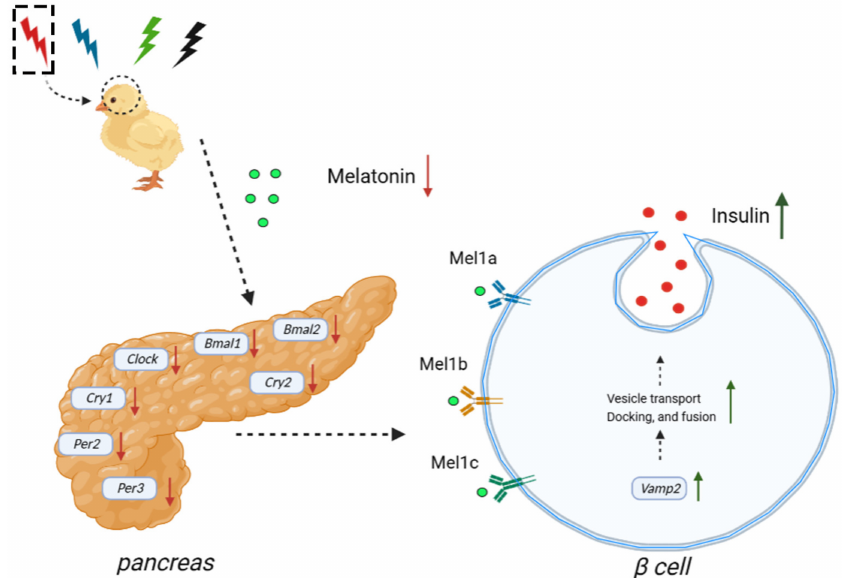
Figure 6. A schematic of our proposed model. Effects of monochromatic light on pancreatic clock genes and rhythmic secretion of insulin in chickens. RL decreased the rhythm of plasma melatonin level and transcription of pancreatic clock gene, stimulating insulin secretion by increasing the expression of cVamp2